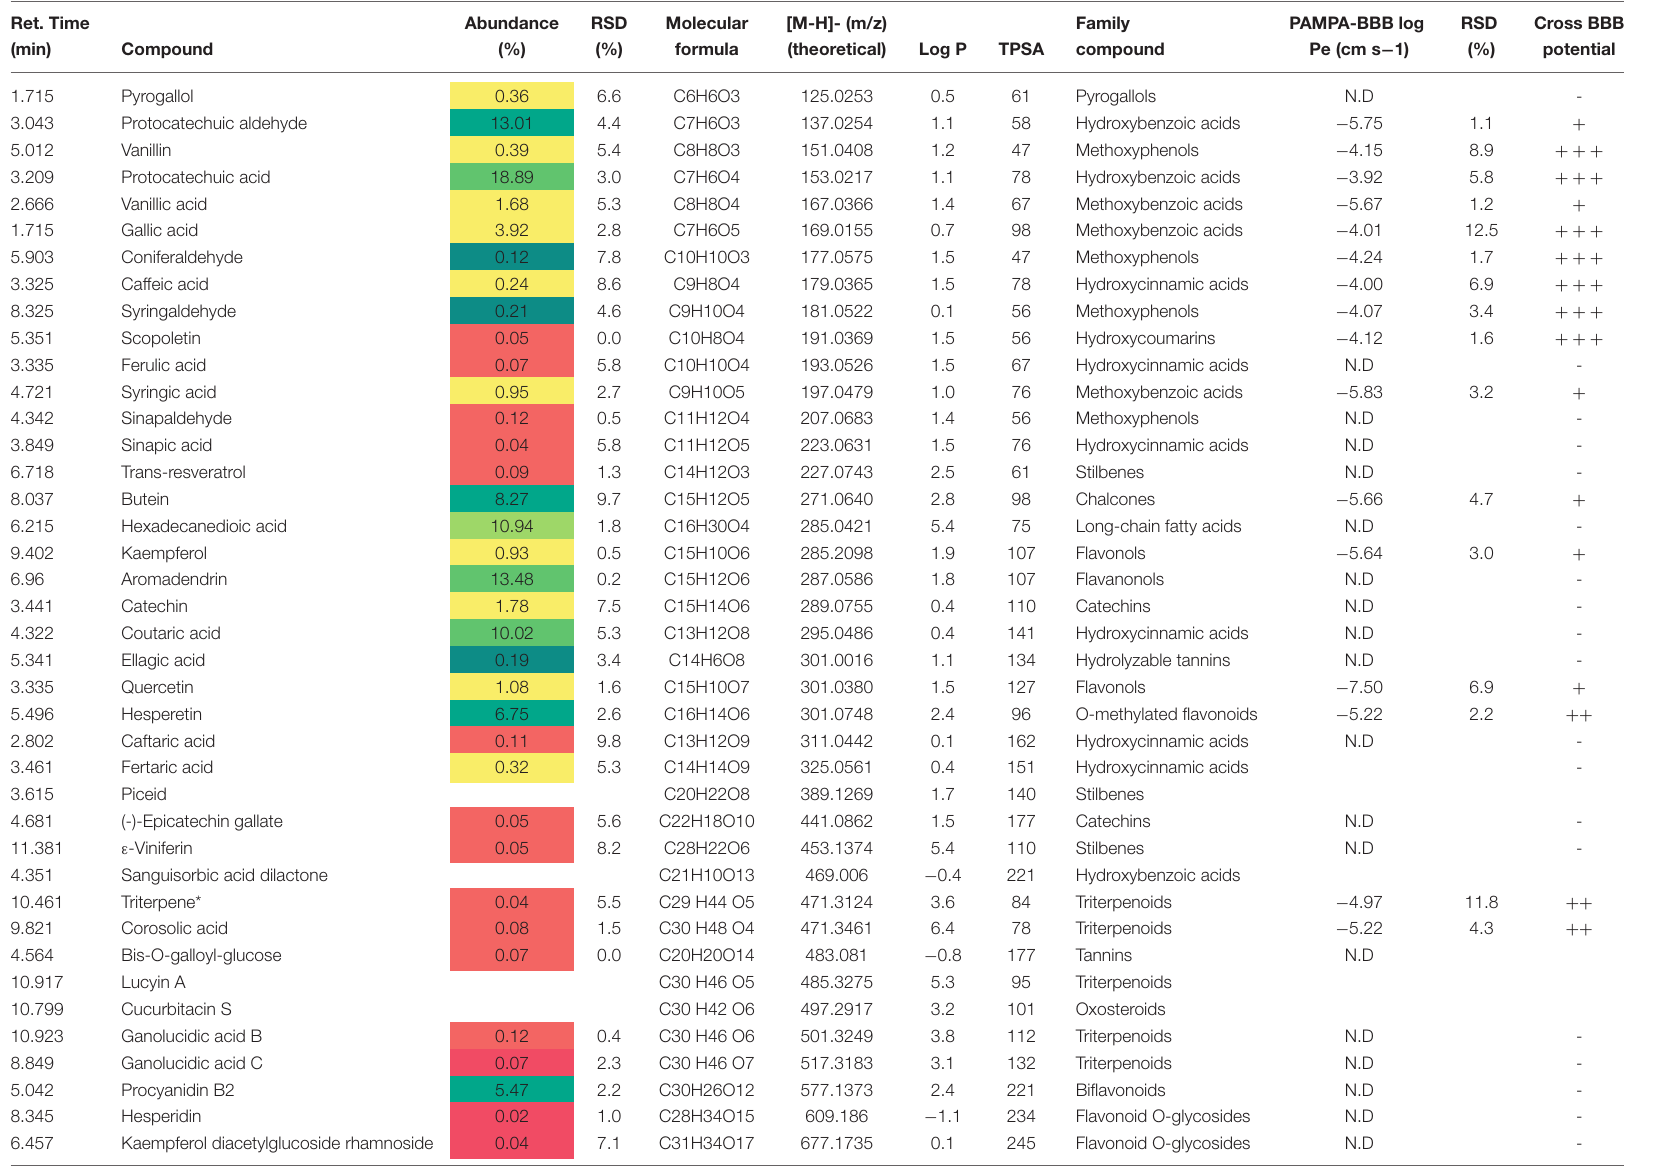
TABLE 3 | Phytochemical profile, abundance (%), and BBB permeability of ASFE (Robinia pseudoacacia, acacia SFE extract). Ret.